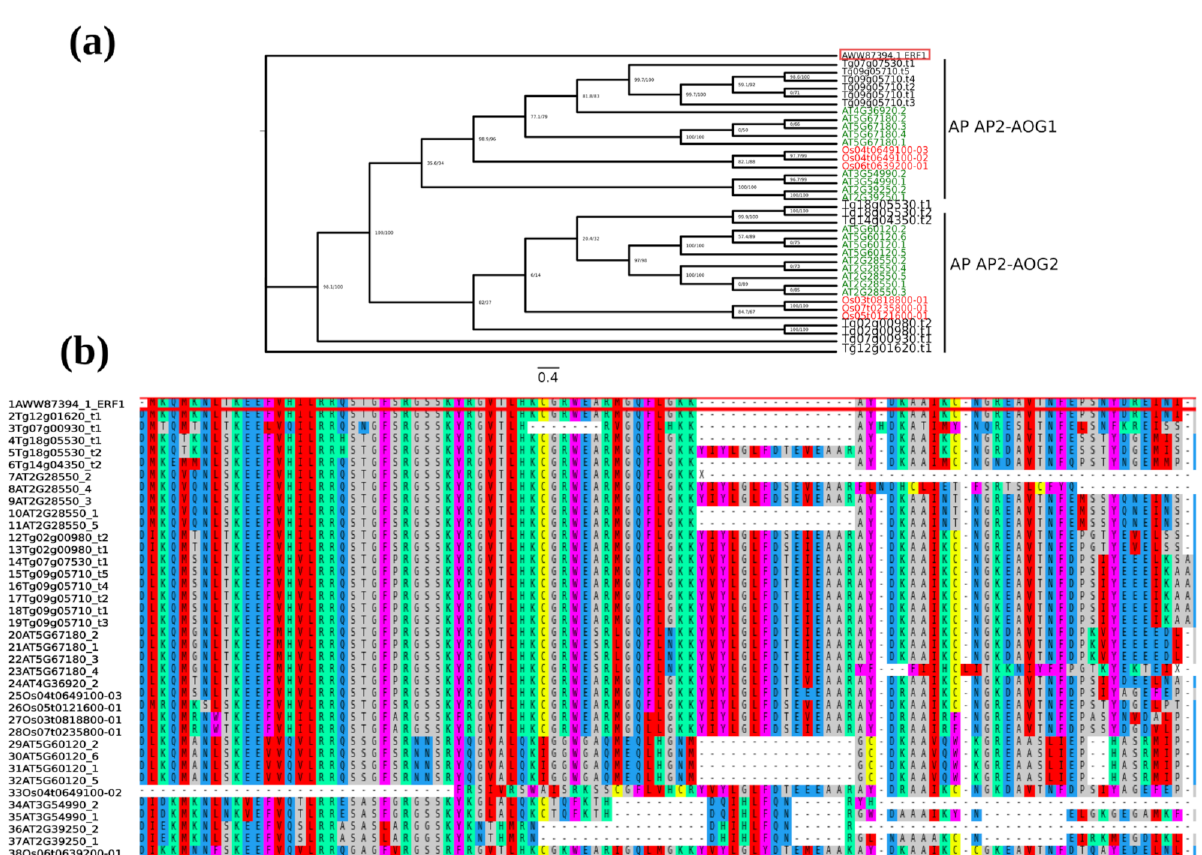
Figure 3. Multiple sequence alignment and phylogenetic tree of AP AP2-AOG1 and -AOG2 subgroups of AP2/ERF family transcription factors. ( a ) AP AP2-AOG1 and -AOG2 subgroups including AWW87394 (TgERF1) orthologous protein is shown in black, Arabidopsis in green, and rice in red, ( b ) TgERF1 multiple alignment to AP AP2-AOG1 and -AOG2 subgroups orthologous